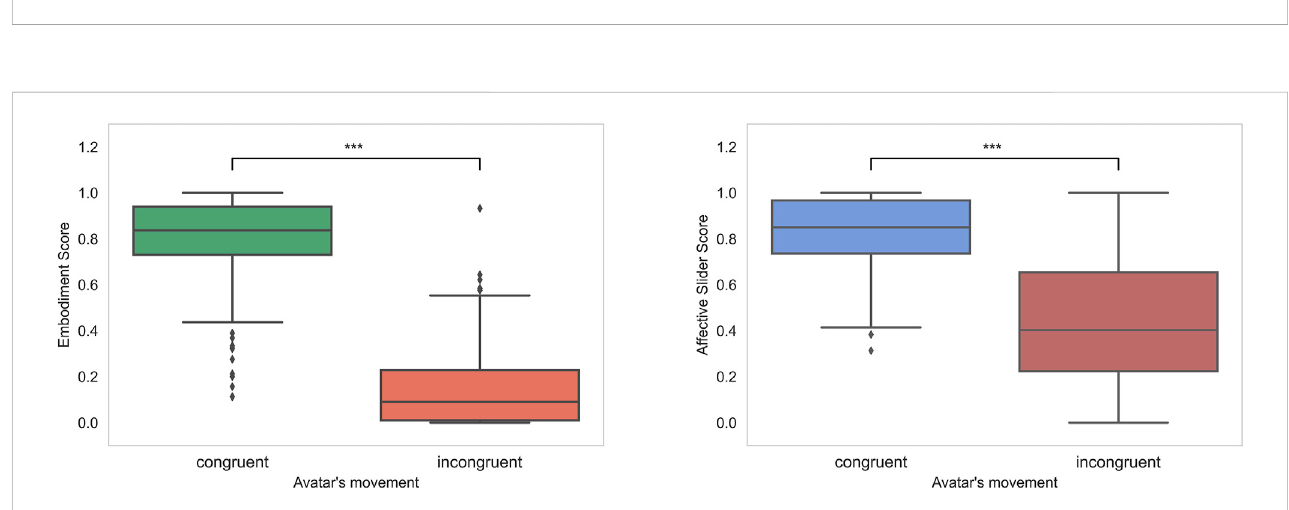
FIGURE 4 Sliding correlation mean and variance with a centered window of 200 frames of (A) long incongruent trials; (B) long incongruent trials classi fi ed as F E depending on the movement type.